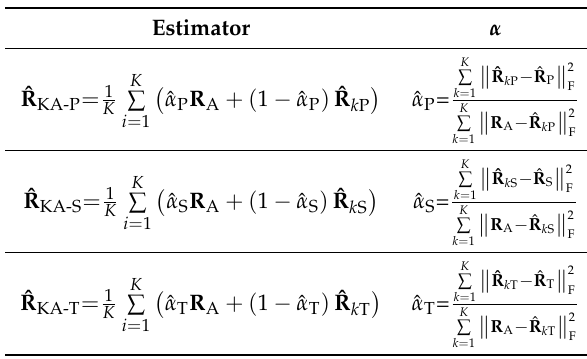
Table 1. Three knowledge-aided structured covariance